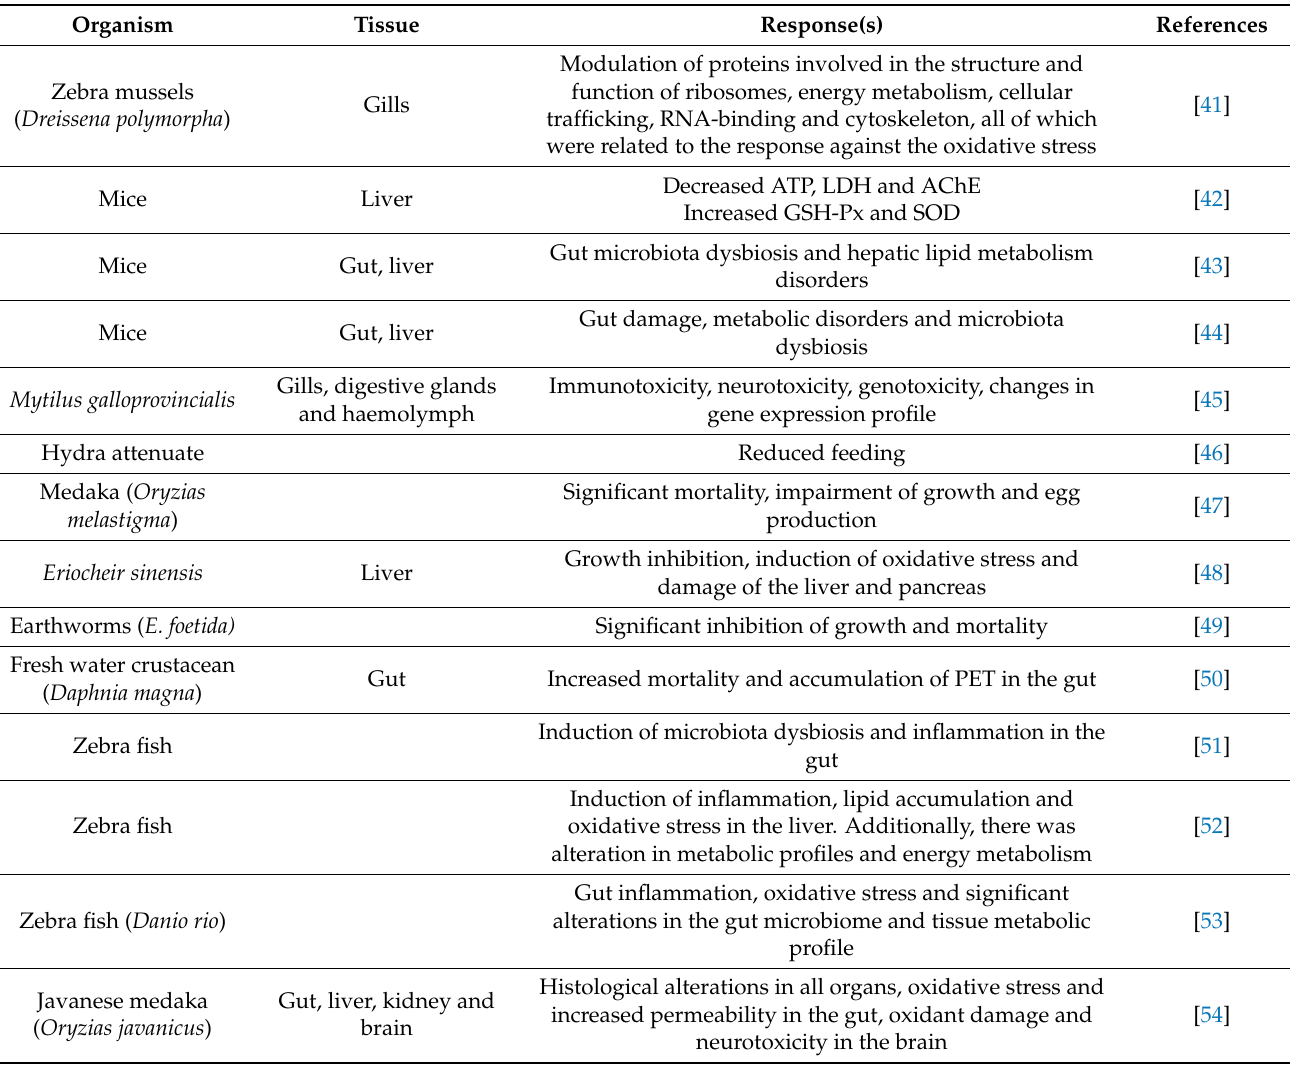
Table 2. Some examples of exposure effect of microplastics as demonstrated by animal